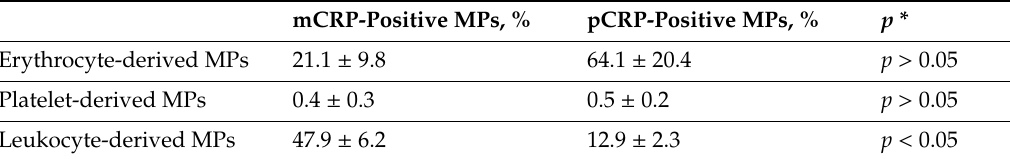
Table 2. CRP-positive